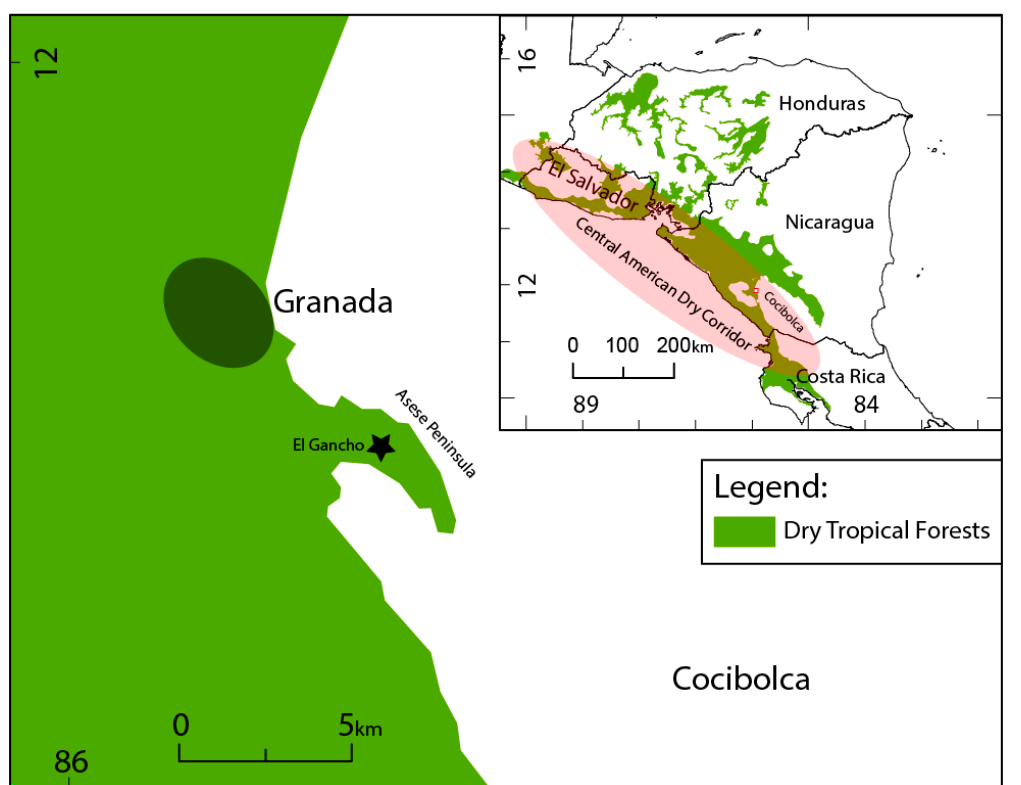
Figure 1. Nicaraguan region of the Central American Dry Corridor (ellipsis) and location of Granada, the Asese peninsula and El Gancho.